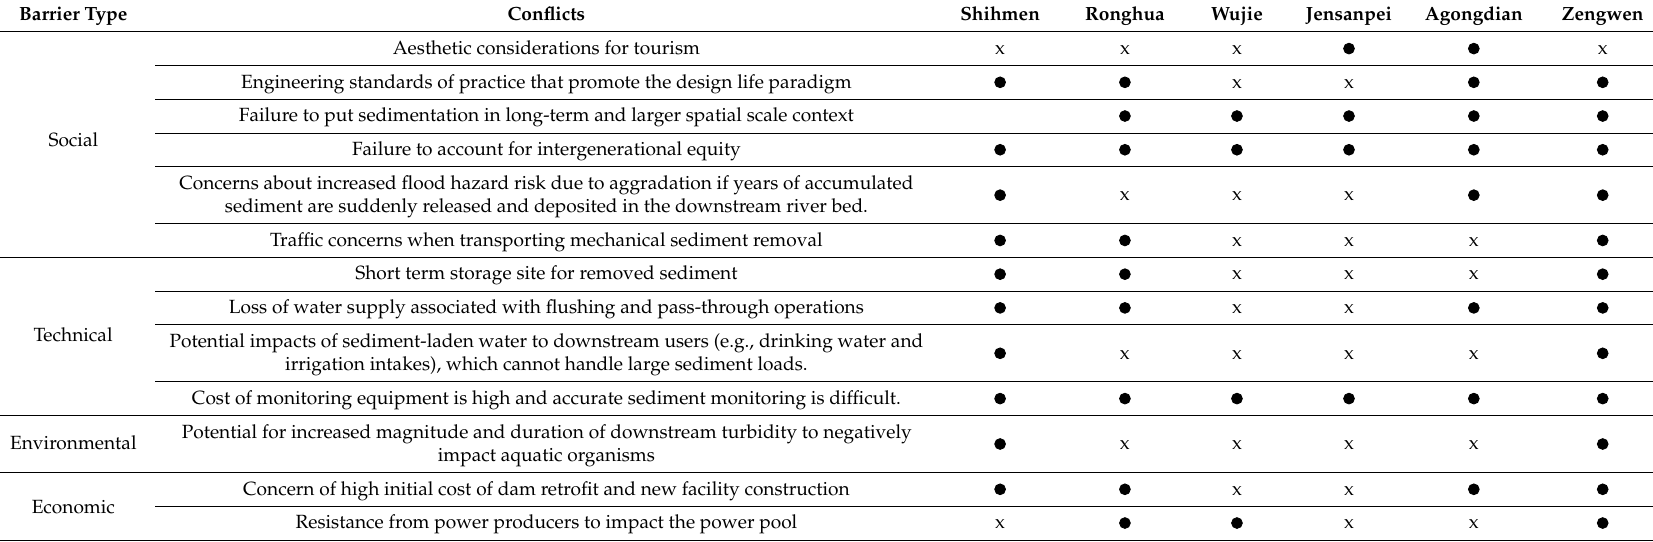
Table 7. Barriers associated with sustainable sediment management at the Taiwan case